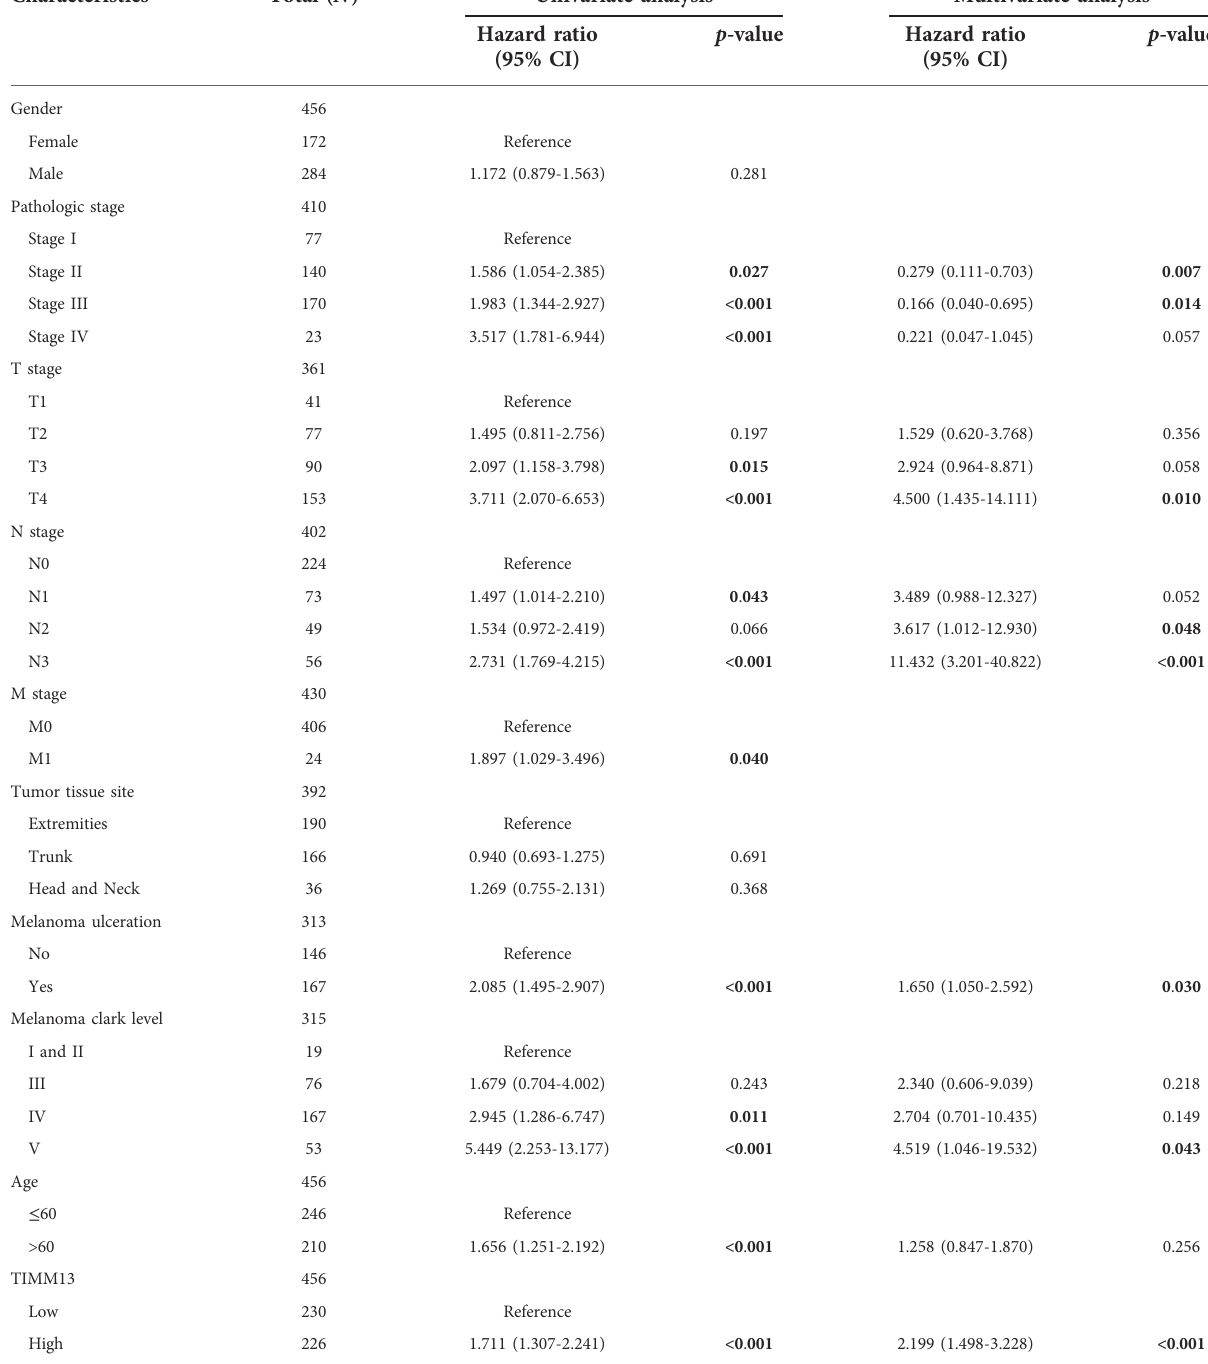
TABLE 1 Univariate and multivariate Cox regression analysis of